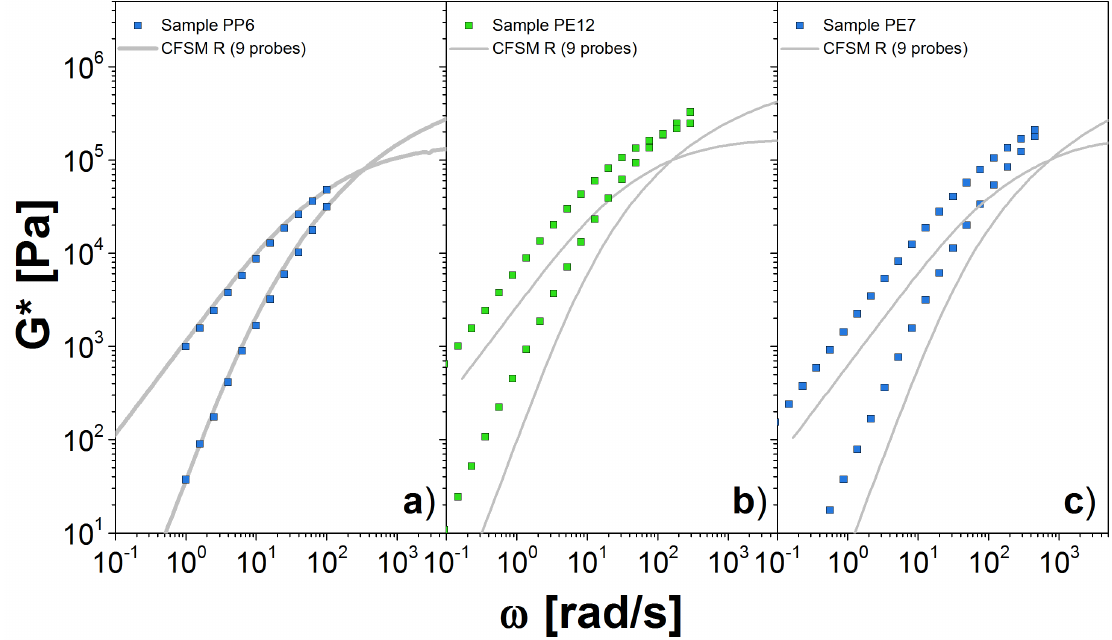
Figure 8. Dynamic moduli for polydisperse linear chains obtained through simulations using the slip-link model for ( a ) PP6 at 120 ◦ C, ( b ) PE12 at 190 ◦ C and ( c ) PE7 at 190 ◦ C. We use nine probes to represent the full distribution W ( M ) . Symbols are the experimental results and lines the theoretical